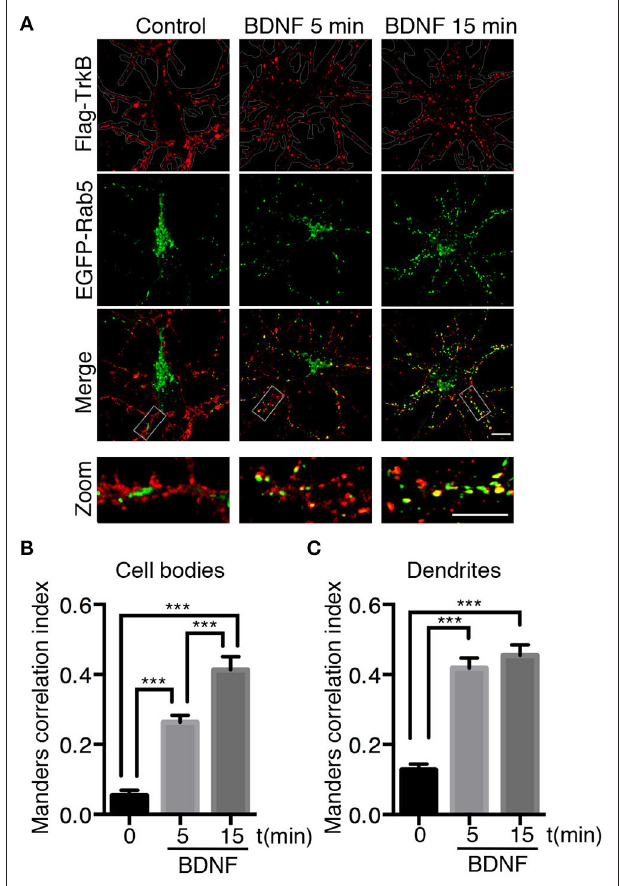
FIGURE 1 | Endocytosed TrkB receptors colocalize with Rab5 after BDNF stimulation in dendrites and cell bodies of hippocampal neurons. Hippocampal neurons (7 DIV) were cotransfected with Flag-TrkB and EGFP-Rab5 (green). After 48h, neurons were incubated with anti-Flag antibodies (red) at 4 ◦ C for 30min. TrkB internalization was stimulated with BDNF at 37 ◦ C for 5 or 15min and then the neurons were fixed and observed by confocal microscopy. (A) In nonstimulated neurons, TrkB receptors are localized in the plasma membrane, and Rab5 is located within the neurons (time 0). After BDNF stimulation, TrkB receptors show an intracellular distribution and colocalize with Rab5. (B) Quantification of colocalization of TrkB-Flag with EGFP-Rab5 in cell bodies using Manders correlation index. (C) Quantification of colocalization of Flag-TrkB with EGFP-Rab5 in primary dendrites using Manders correlation index. N = 30 neurons from 3 different experiments. The results are expressed as the mean ± SEM. *** p < 0.001 by ANOVA with Bonferroni’s